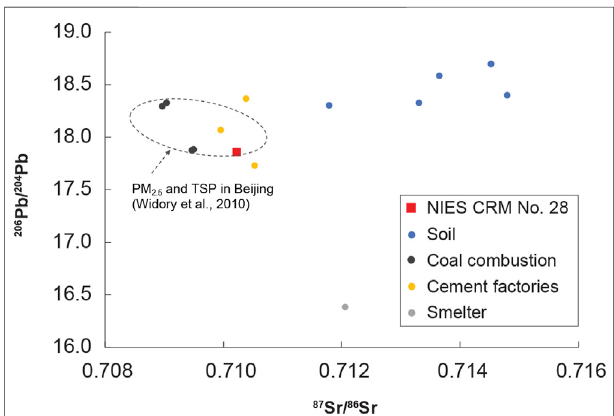
FIGURE 3 | 206 Pb/ 204 Pb ratios vs . 87 Sr/ 86 Sr. Soils and atmospheric aerosols collected near sources (coal combustions, smelters, and cement factories) in Beijing as reported by Widory et al. (2010) are indicated for comparison. All Sr isotopic data were adjusted to the NIST SRM 987 87 Sr/ 86 Sr value of 0.710248.